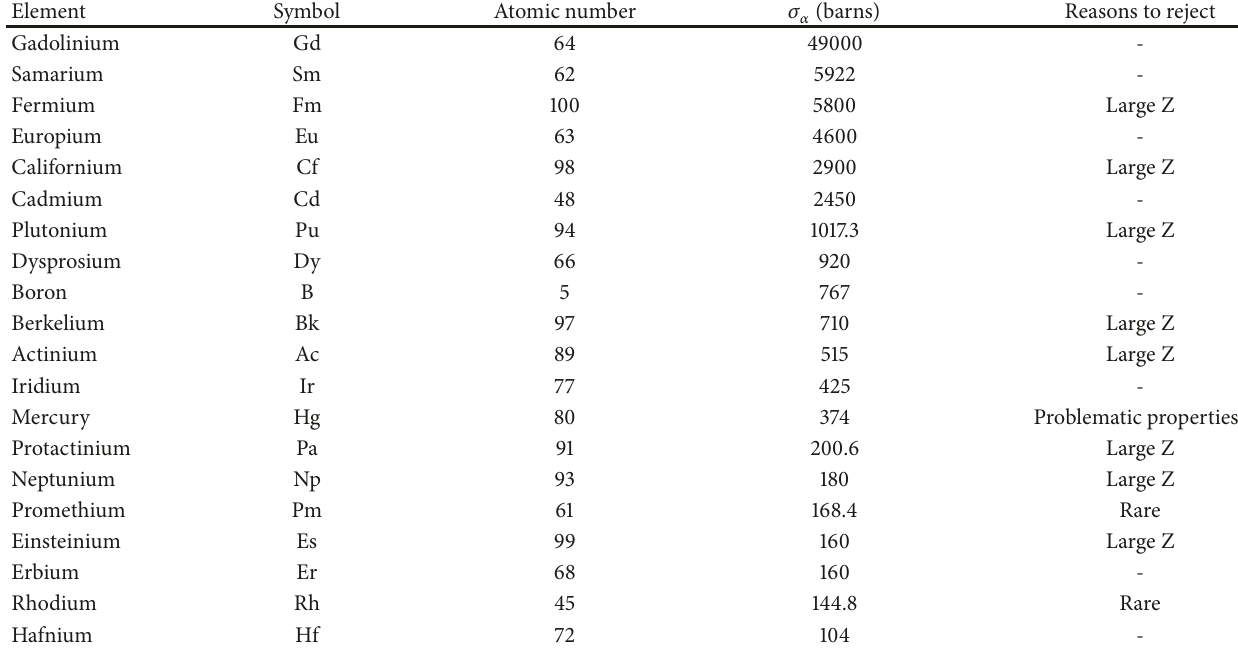
Table 1: Elements with the highest absorption capability classified with descending thermal microscopic absorption cross sections ( 𝜎 𝛼 ). Element